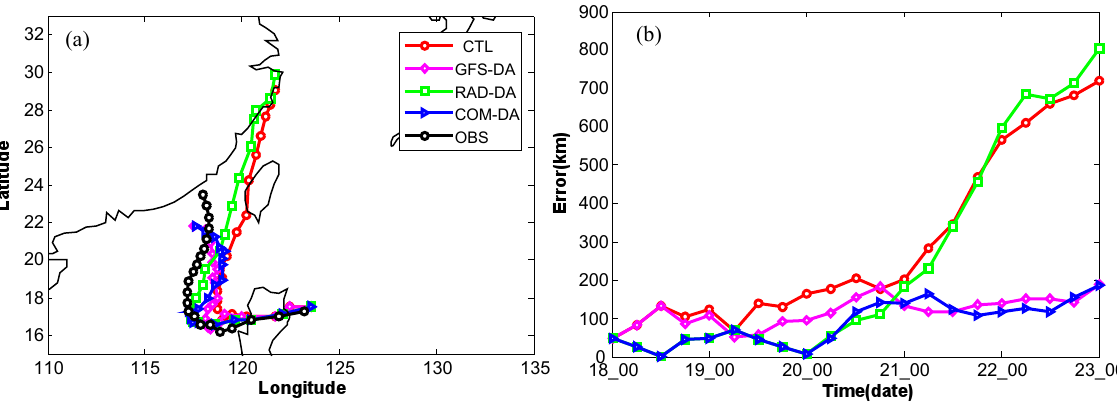
Figure 4. Forecasted ( a ) tracks of typhoon Megi (2010) and ( b ) corresponding errors (unit: km) for experiments; CTL (in red), RAD-DA (in green), GFS-DA (in purple), and COM-DA (in blue). The best-track from the JTWC (OBS, in black) is also given as a reference.